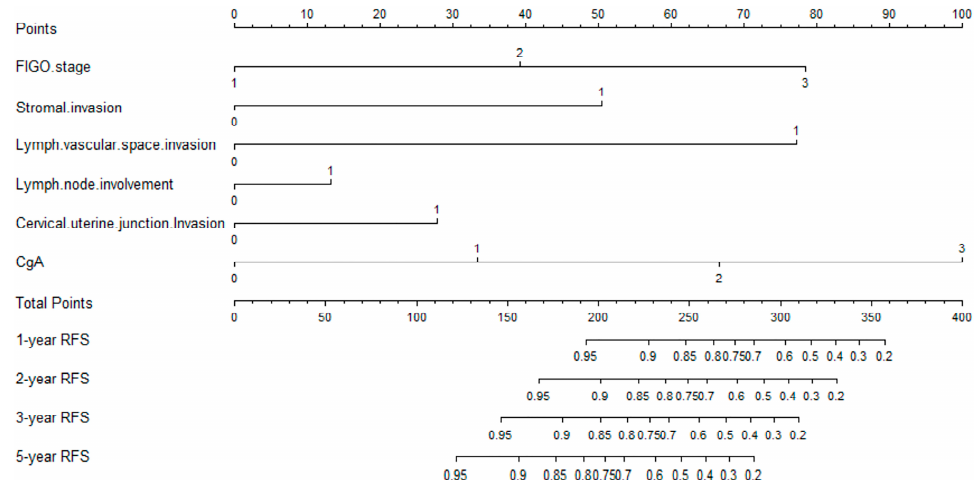
Figure 1. The nomogram model for predicting the recurrence-free survival of neuroendocrinal carcinoma of cervix after surgery. (Each variable from the second row to the seventh row corresponds to a point value in the first row “point”. Then, sum the scores of each variable to obtain the “total point”, and finally derive 1-year, 2-year, 3-year and 5-year recurrence-free survival (RFS)).